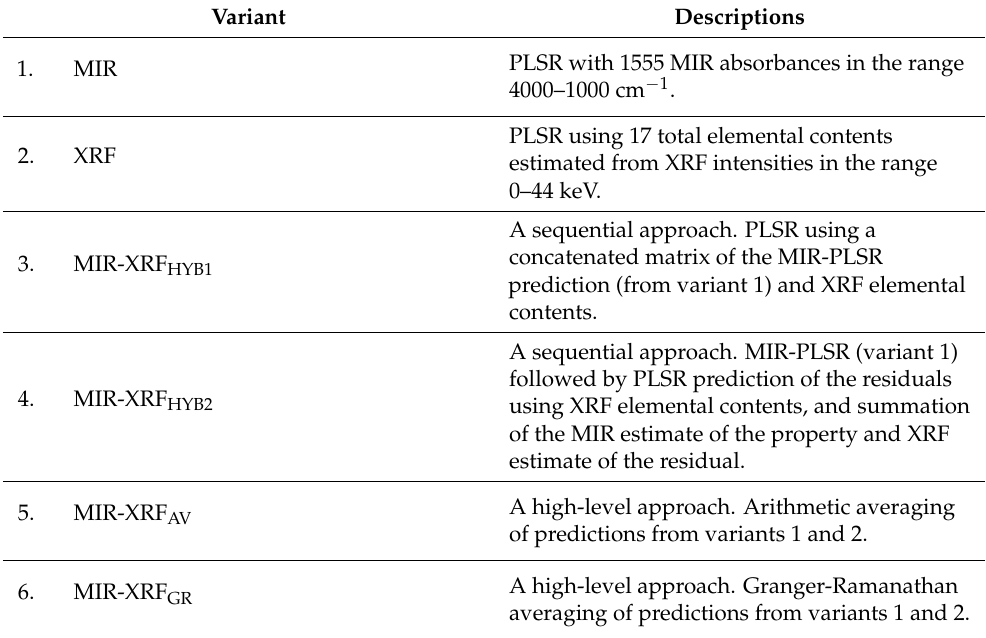
Table 1. Names and descriptions of modelling approaches. PLSR = partial least squares